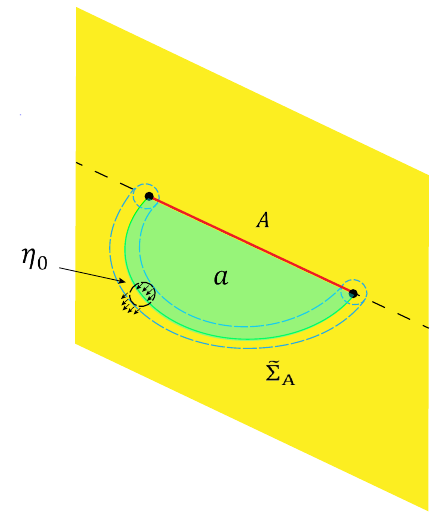
˜Σ , outlined by the dotted blue lines. Only the zero- × A 1